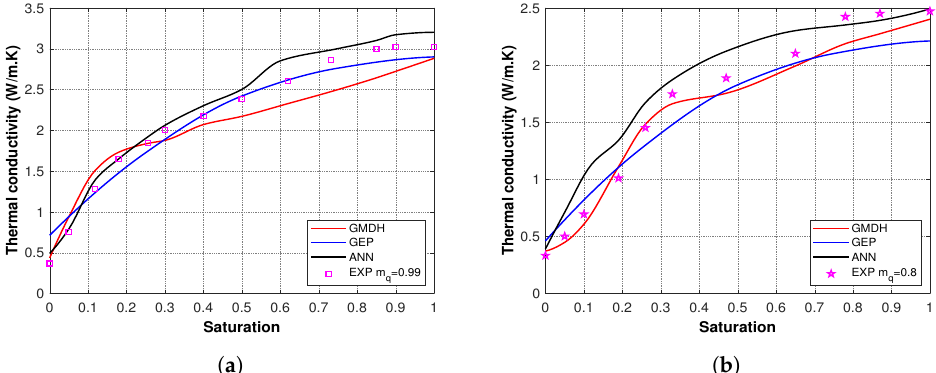
Figure 11. Model prediction of three different networks and experimental results ( a ) for quartz content m q 0.8 ( b ) m q